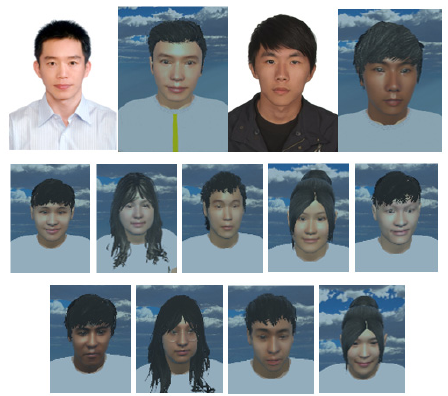
Figure 5. 3D facial models based on photos of the users.